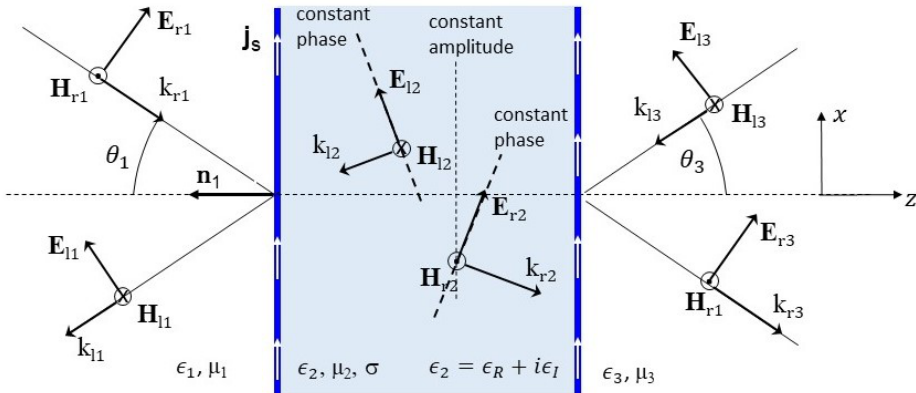
Figure 2. Constant-phase and constant-amplitude planes for the electromagnetic fields propagat- ing conductors.